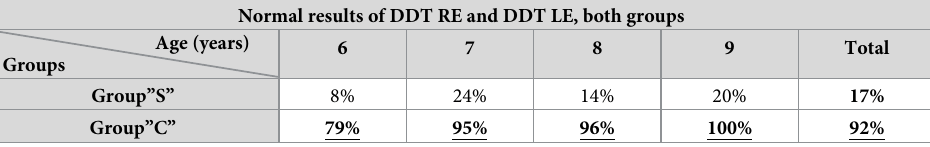
Table 4. Percentage of normal results obtained simultaneously for DDT RE and DDT LE, in both study groups, by